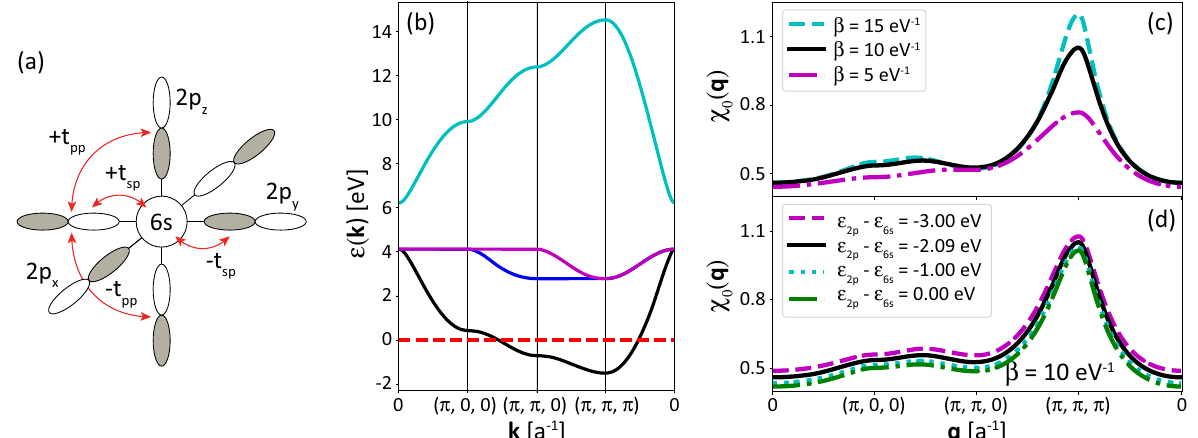
Fig. 1 Model de fi nition and electronic properties in the noninteracting limit. ( a ) Lattice structure of the three-dimensional, four-orbital model. A Bi 6 s orbital is surrounded by six O 2 p σ orbitals. Red arrows indicate the relevant hopping integrals, with the phase factor included in hole language. ( b ) The band structure in the noninteracting limit, α sp = 0. The horizontal red line indicates the Fermi energy at a target fi lling of 1 hole per Bi atom. ( c ) For the target fi lling, the noninteracting charge susceptibility χ 0 ( q ) is computed using the lowest energy band (black) in panel (b) for three different temperatures. As the temperature is lowered, the peak at q = ( π , π , π ) a − 1 grows. ( d ) At the fi xed temperature ϵ − ϵ β = 10 eV − 1 , χ 0 ( q ) for four values of the charge transfer energy 2 p 6 s , the difference in the on-site energy of the O 2 p σ and Bi 6 s orbitals. The peak at q = ( π , π , π ) a − 1 is approximately independent of the charge transfer